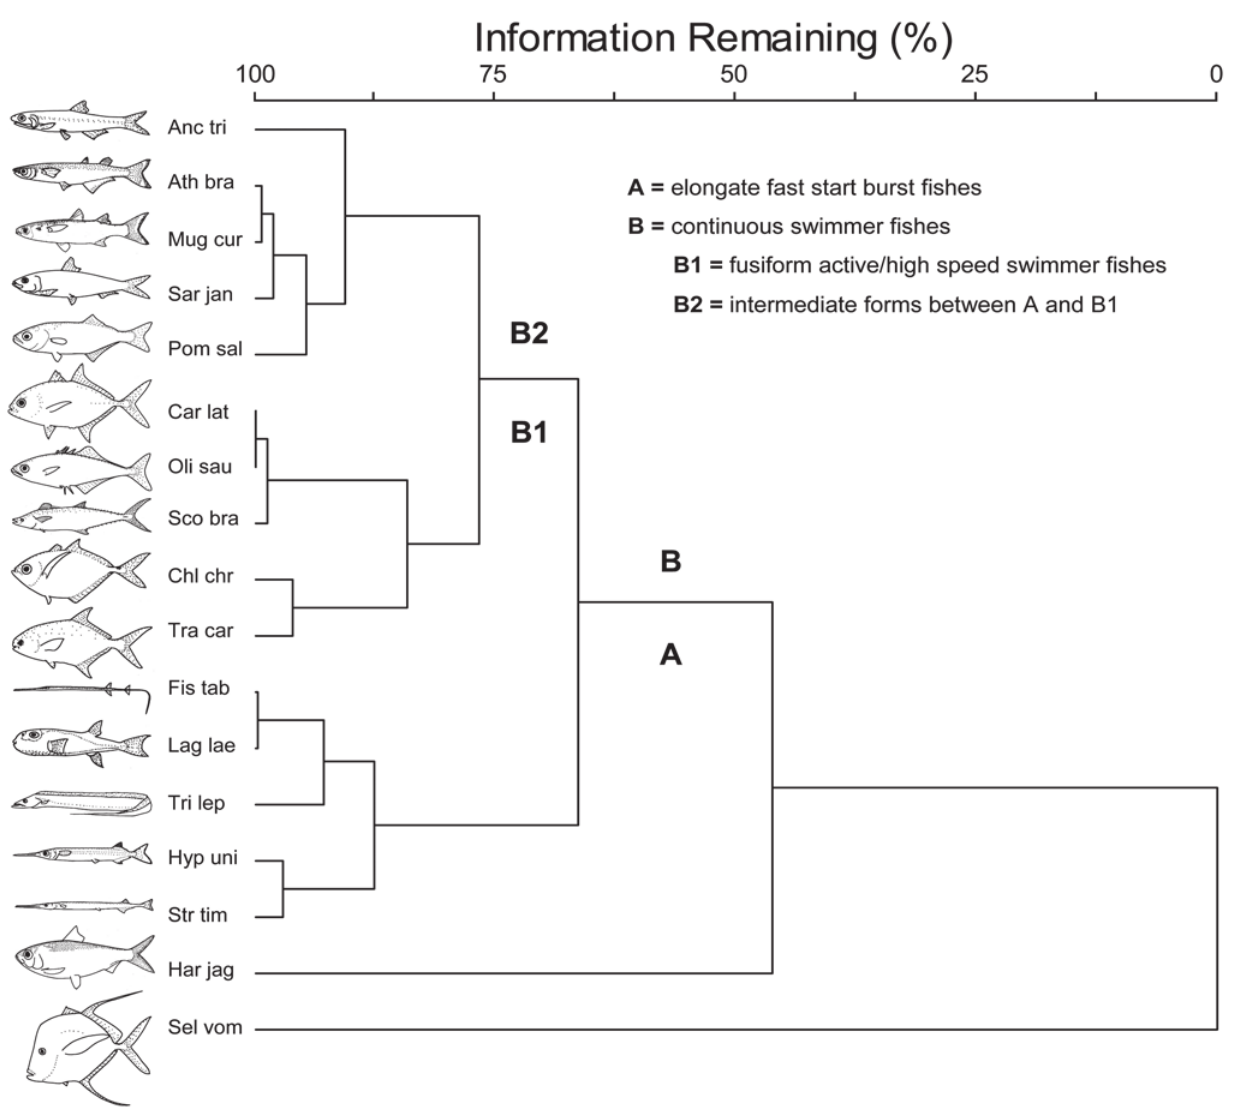
Fig. 3. Dendrogram of ecomorphological relationships (similarity) for the 17 nektonic fish species studied. Cluster analysis is by the Euclidean distance measure and Group Average linkage method using the same scores ( i.e. , coordinates) calculated for PCA and plotted in Fig. 2 (cophenetic coefficient r = 0.86). Anc tri = Anchoa tricolor ; Ath bra = Atherinella brasiliensis ; Car lat = Caranx latus ; Chl chr = Chloroscombrus chrysurus ; Fis tab = Fistularia tabacaria ; Har jag = Harengula jaguana ; Hyp uni = Hyporhamphus unifasciatus ; Lag lae = Lagocephalus laevigatus ; Mug cur = Mugil curema ; Oli sau = Oligoplites saurus ; Pom sal = Pomatomus saltatrix ; Sar jan = Sardinella janeiro ; Sco bra = Scomberomorus brasiliensis ; Sel vom = Selene vomer ; Str tim = Strongylura timucu ; Tra car = Trachinotus carolinus ; Tri lep = Trichiurus lepturus . There is no